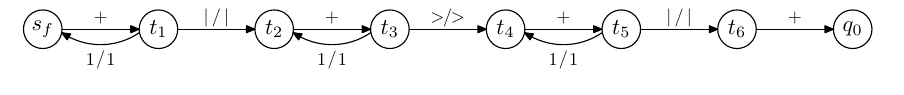
Fig. 4: Sequence of states added to T C